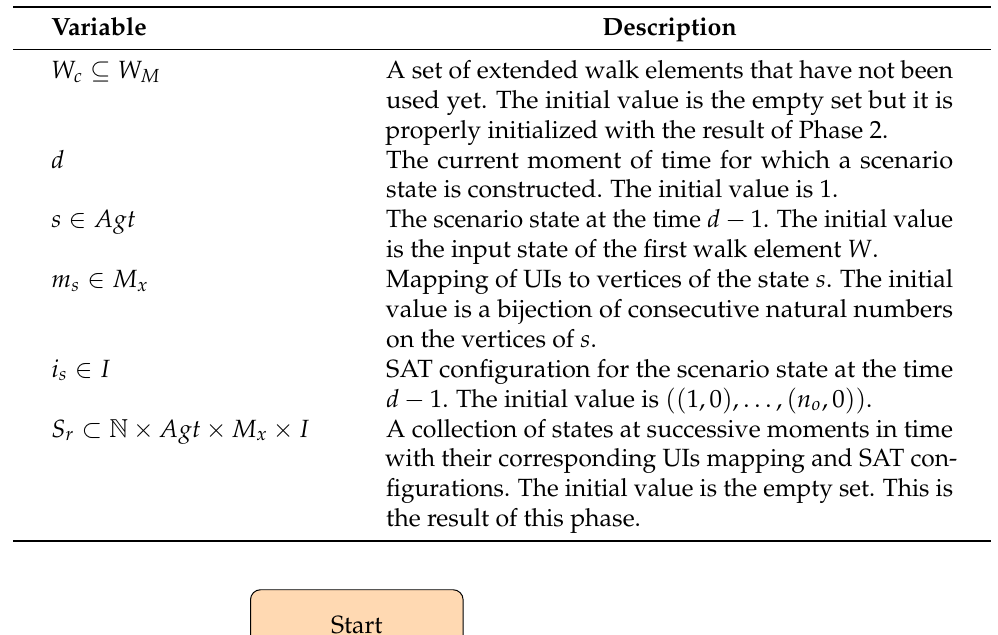
Table 13. Auxiliary variables for the Phase 1